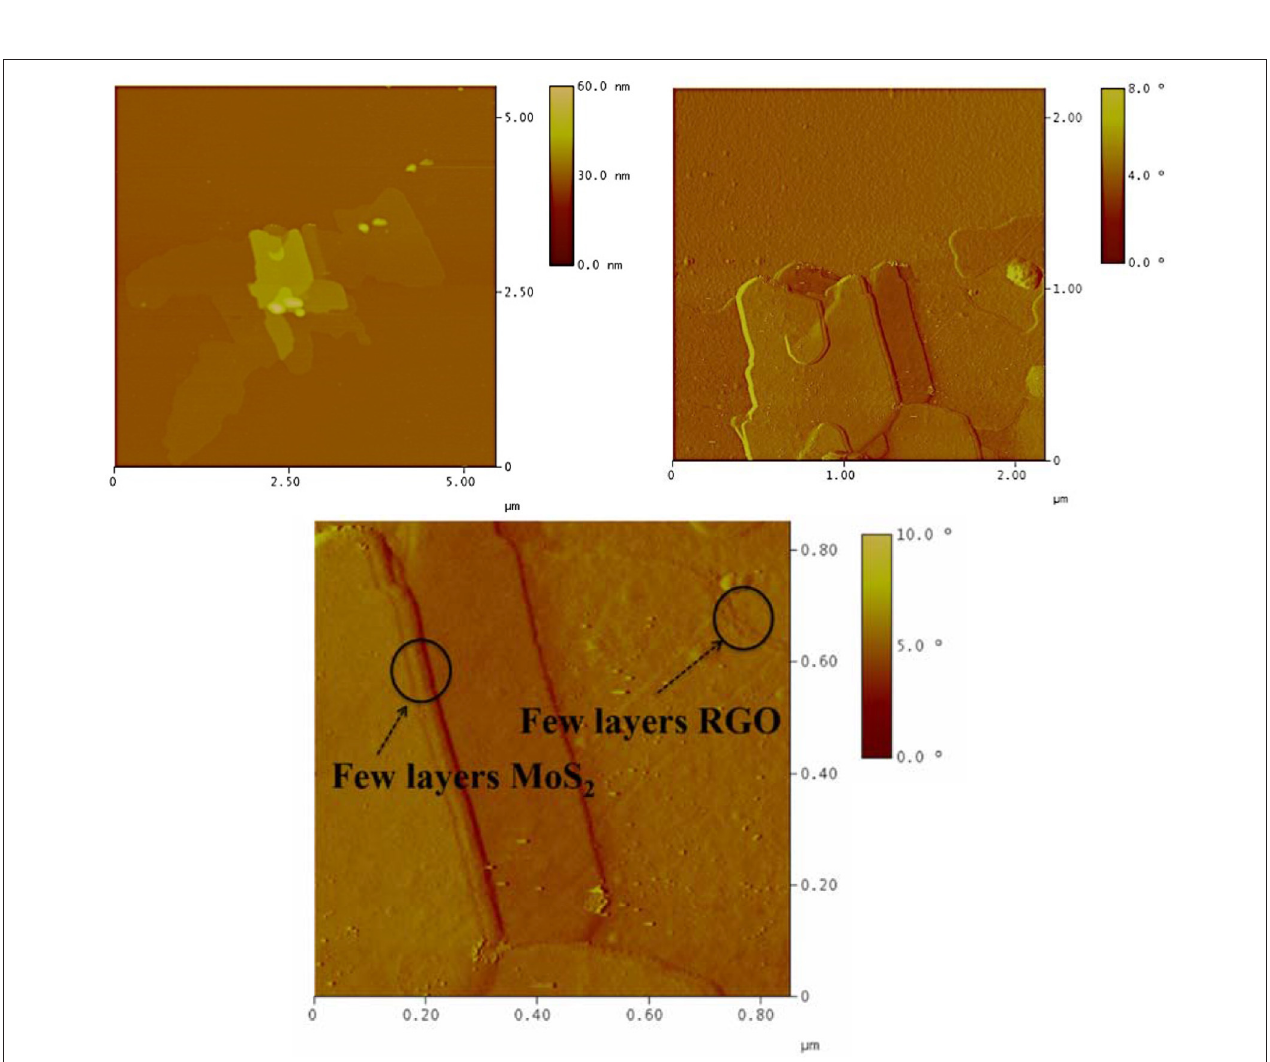
FIGURE 3 | AFM height (left) and phase ( right and bottom ) images of MoS 2 /r-GO nanocomposite.